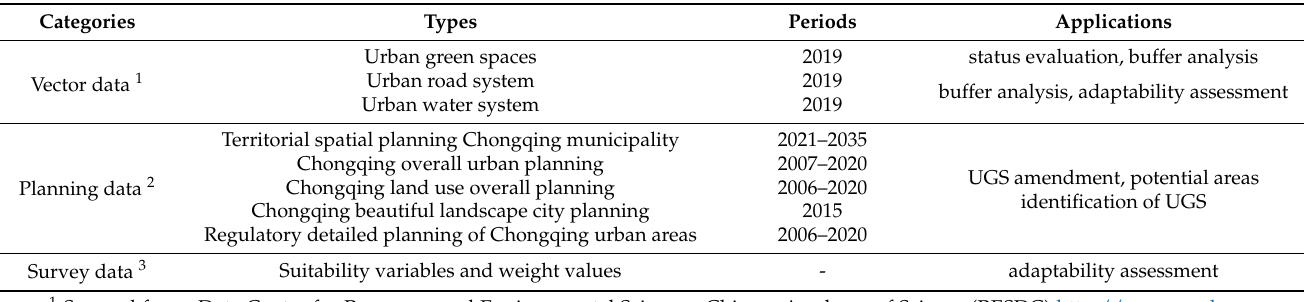
Table 1. UGS database of Chongqing urban